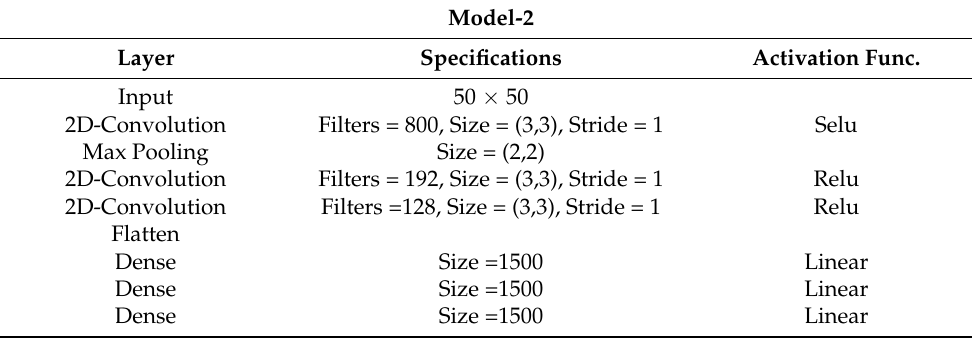
Table 3. Details and architecture of